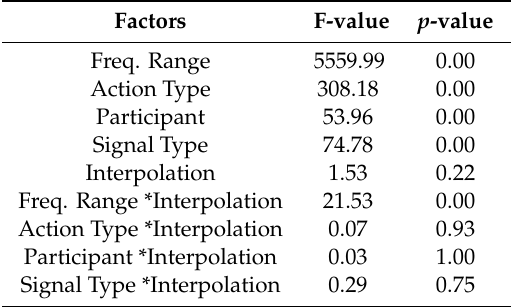
Table 2. Partial Results of the N-way ANOVA on RMSE.